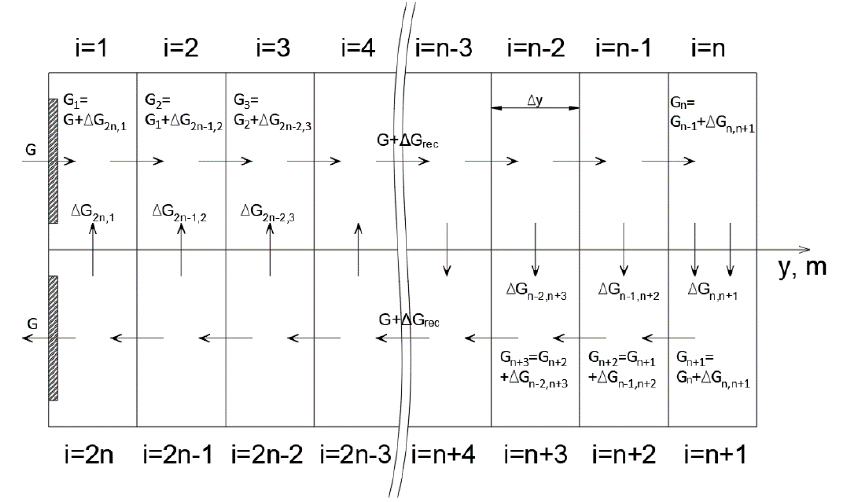
Figure 3. Calculation scheme of the furnace and the scheme of movement of furnace gases.